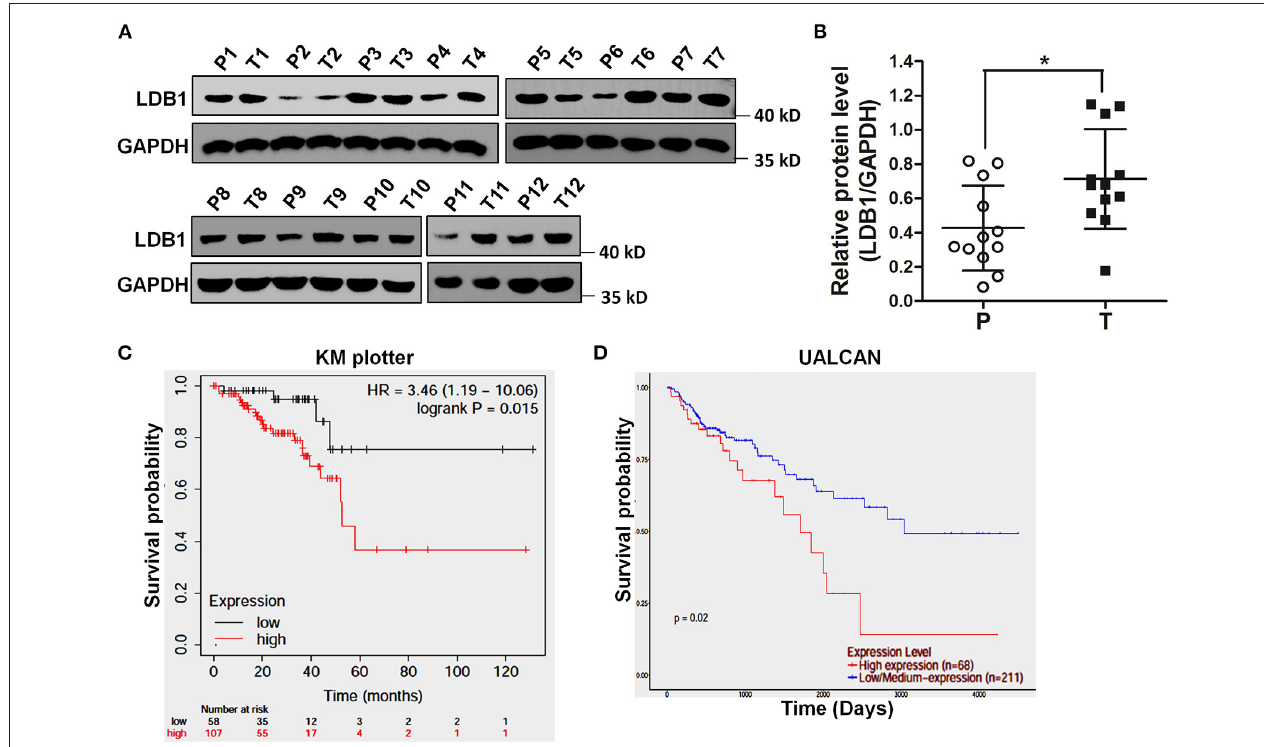
FIGURE 1 | The expression level of LDB1 in colorectal cancer and its effects on the prognosis of patients. (A,B) . Twelve pairs of paracancerous (P) and tumor (T) tissues from colorectal cancer (CRC) were lysed for western blot to detect the expression of LDB1. GAPDH was used as a loading control (A) . The optical density analysis was also carried out (B) . (C) Effect of LDB1 expression level on rectum adenocarcinoma patient survival was analyzed online by KM plotter. (D) Effect of LDB1 expression level on colon adenocarcinoma patient survival was analyzed online by UALCAN. * p < 0.05.